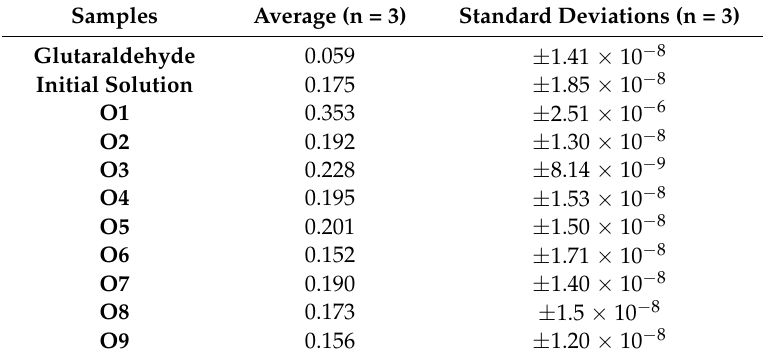
Table 1. Average of the optical absorption values (a.u.) at the glutaraldehyde absorption peak (285 nm) obtained for each curve and respective standard deviations.